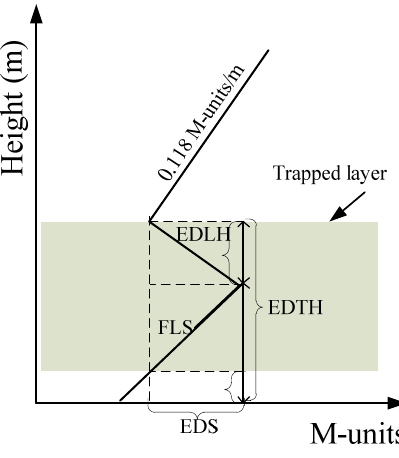
Figure 3. Elevated duct